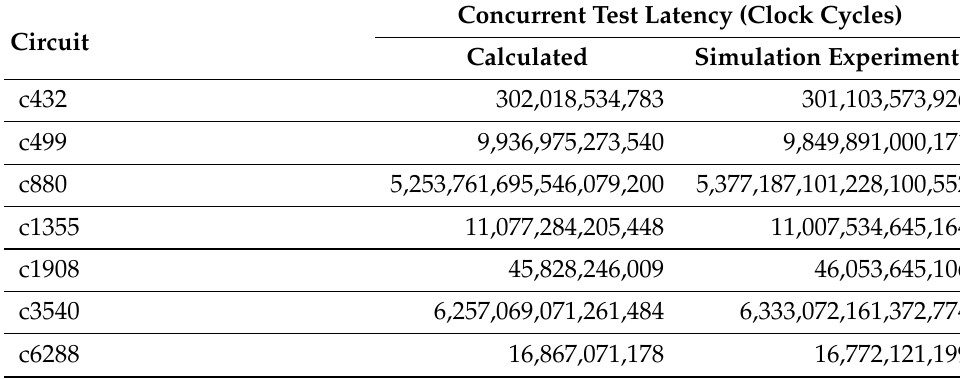
Table 4. Concurrent test latency for some of the ISCAS’85 Benchmarks